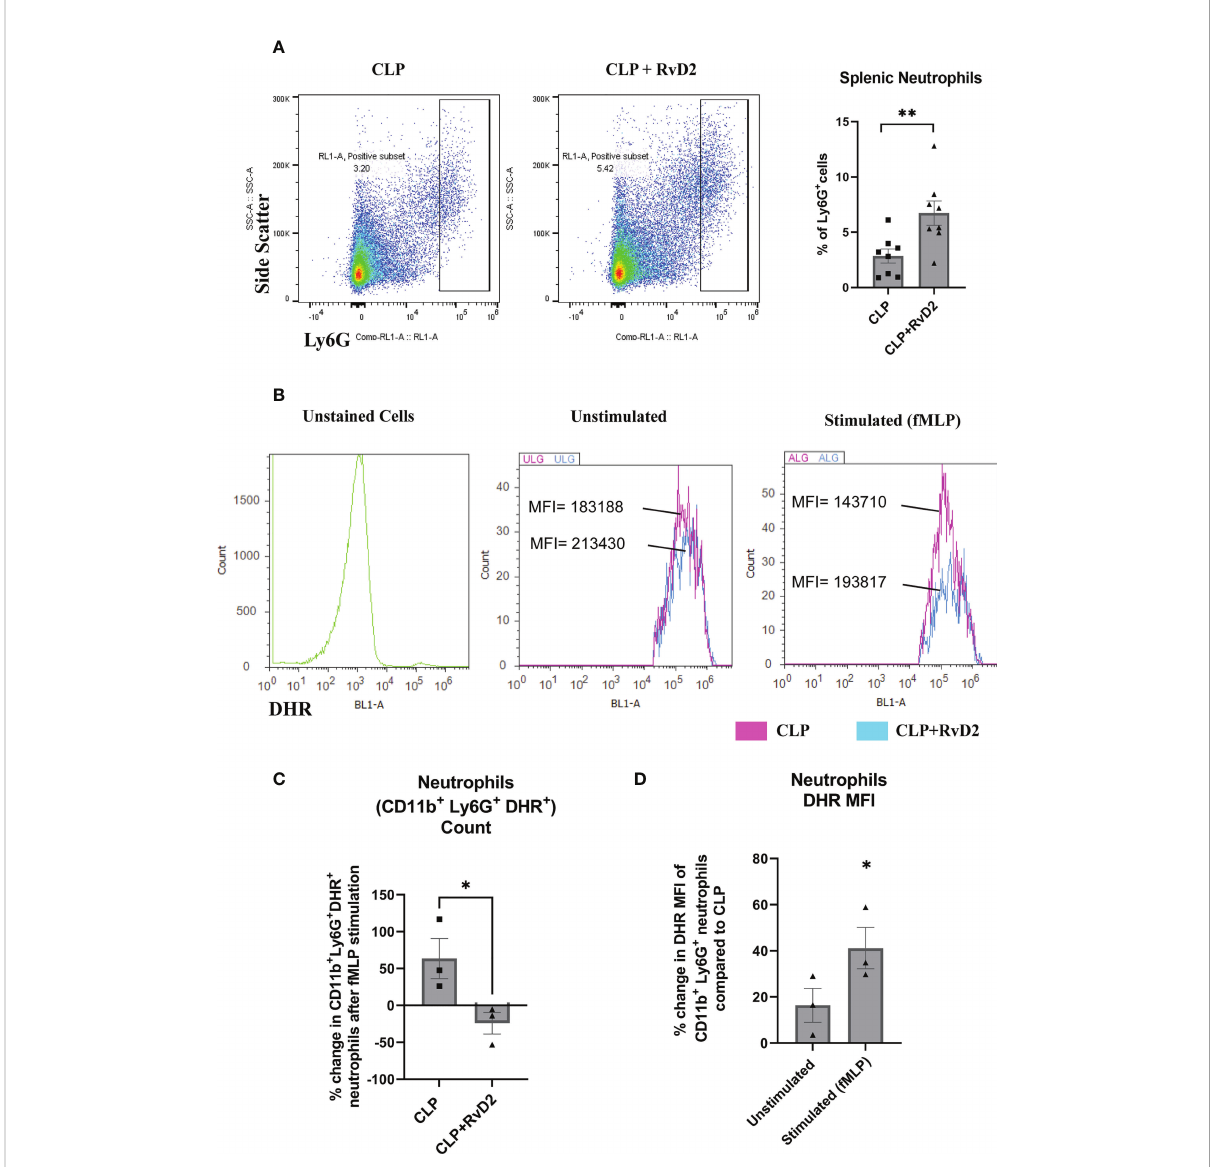
FIGURE 4 (A) CLP mice were given vehicle saline or RvD2 48h after surgery. Mice were sacri fi ced 24h later and spleen samples were taken. Ly6G + splenic neutrophils were gated and counted based on side scatter and Ly6G expression. RvD2 increased the number of Ly6G + splenic neutrophils. Data are mean ± S.E.M. for n = 8 in each group, **P<0.01. (B) ROS production (DHR + cells) in CD11b + Ly6G + splenic neutrophils was measured in unstimulated (basal) and fMLP stimulated cells. Cell density plots (Y-axis: count; X-axis: DHR; oxidative burst) shows oxidative burst in cells